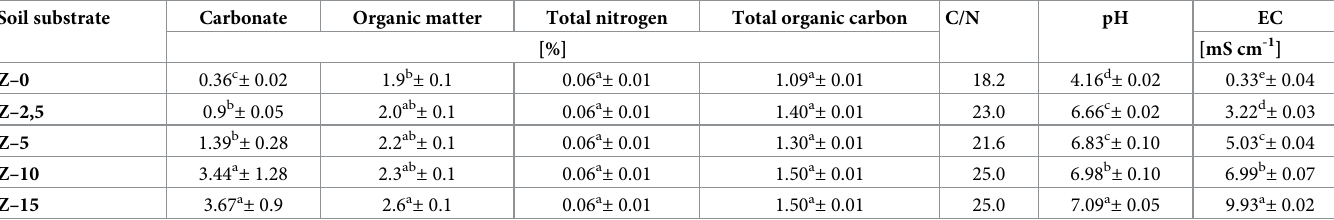
Table 4. Selected chemical properties of the soils and the mixtures (average value ± standard deviation). Soil